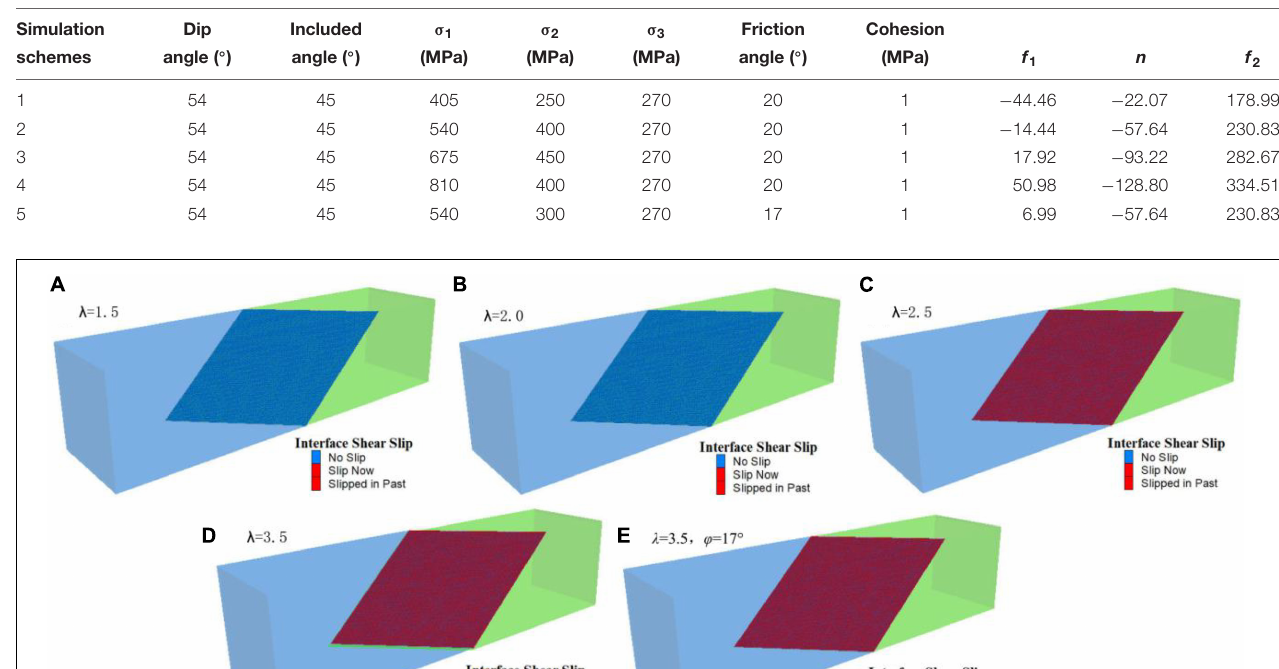
TABLE 1 | Summary of simulation schemes and calculation results.